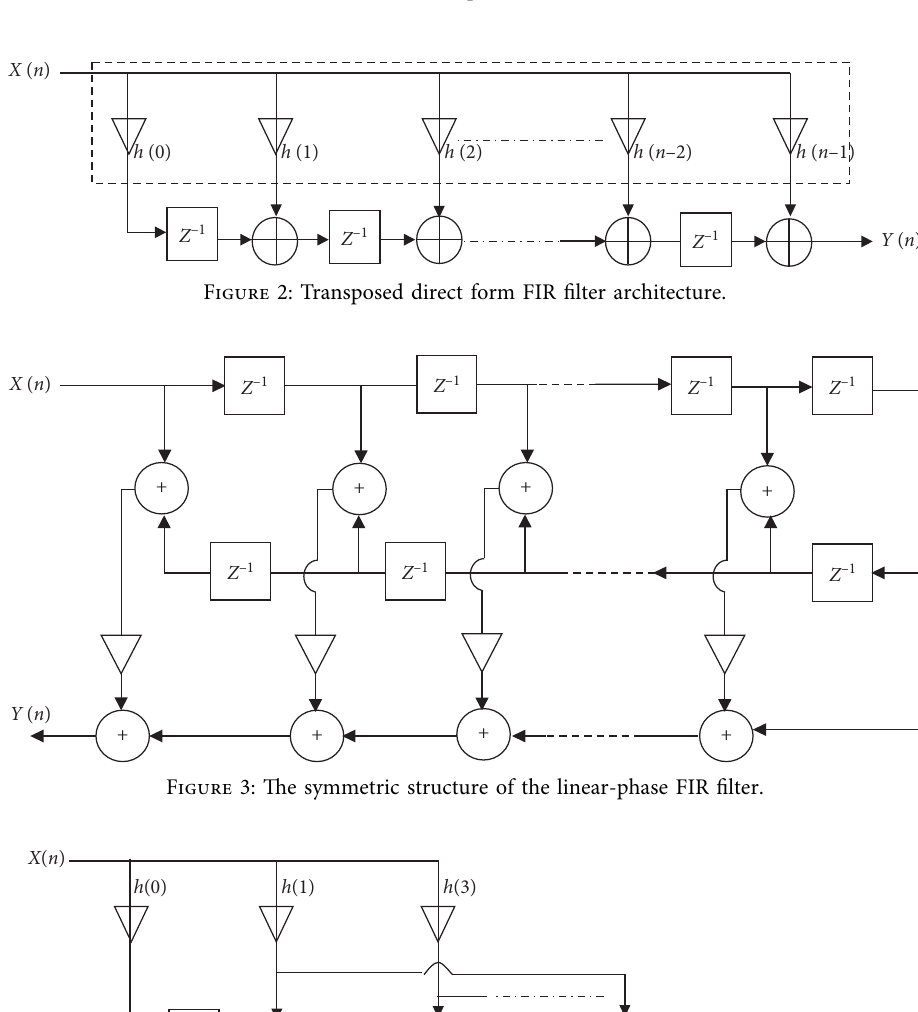
Figure 1: Direct form low-pass FIR filter architecture.